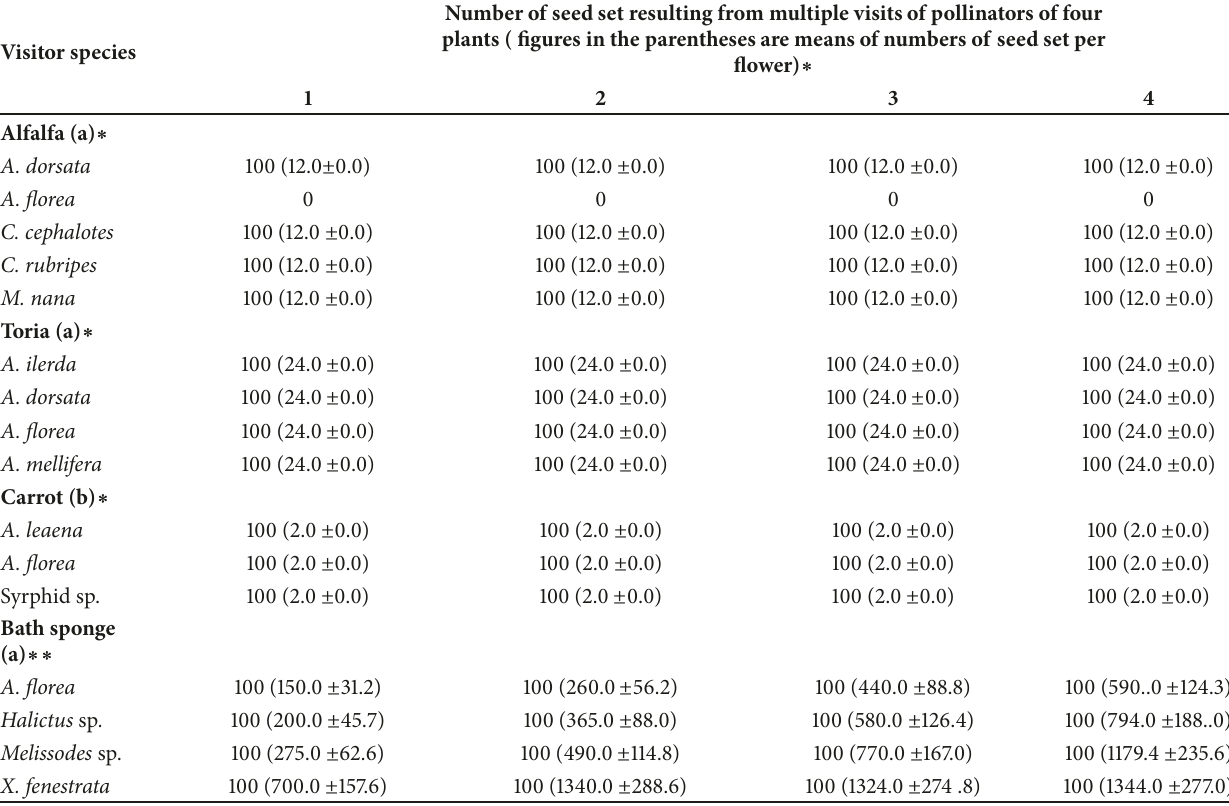
Table 4: Fruit/seed set resulting from multiple visits of different flower visitors of four plant species. Number of seed set resulting from multiple visits of pollinators of four plants ( figures in the parentheses are means of numbers of seed set Visitor species